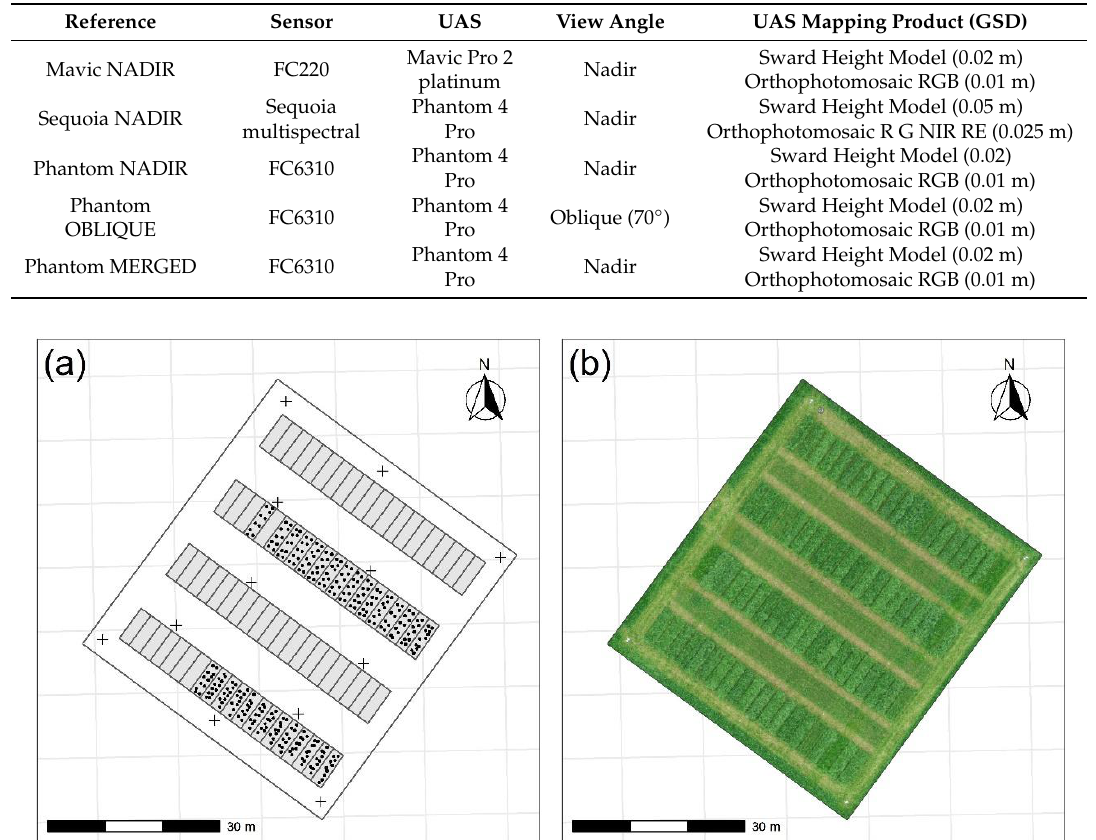
Figure 1. Study site composed of 4 lines of 20 plots (10.5 m²). Left panel (a)ground control points ( + , 12) evenly distributed across the site. Sward height measurements ( ∙ , 296) were realized in 29 plots in two separate lines. Right panel (b): RGB orthophotomosaic from DJI Mavic pro 2 Platinum (1 cm ground resolution).